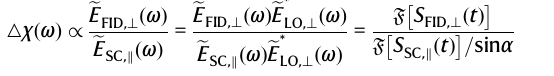
2904cm − 1 of the MOA. d Mode-resolved MOA spectrum ofnitrogendioxide with a recording time of 1s. The spectral range from 87.08THz to 87.10THz is shown to reveal the series lines of the Q Q(K a = 4) subbranch; the blue curve is the contour fi tting. e Line of the Q Q(7 4,3 ) transition is composed of several combs with a 108.4MHz spacing. f the single comb with 90kHz